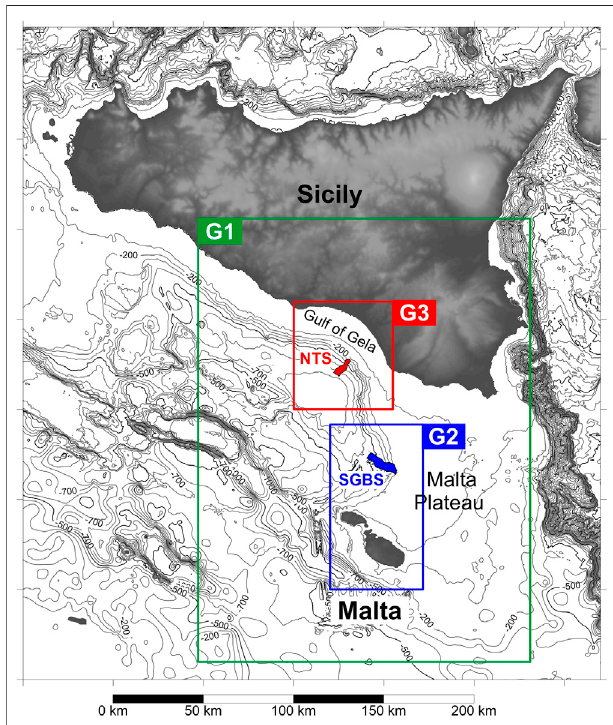
FIGURE 4 | Tsunami computational grids: the larger (G1) is characterized by a 250-m step, while the smaller ones (G2 and G3) have higher resolution (50-m spaced nodes) and are focused on the SGBS and NTS areas, respectively. The propagation of the tsunami over domains with different spatial intervals is possible through the nested-grids